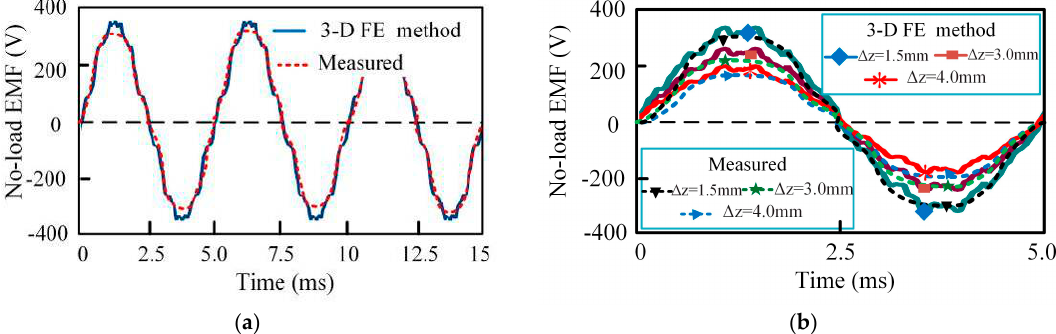
Figure 17. No-load EMF at different CR axial displacement: ( a ) waveform of no-load back EMF at Δ z = 0, ( b ) peak value of no-load back EMF versus displacement when Δ z > 0 (1.5 mm, 3.0 mm, 4.0 mm).